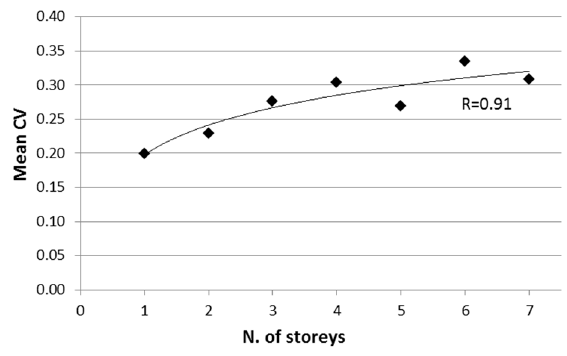
Figure 9. Logarithmic regression between mean values of CV and number of storeys.